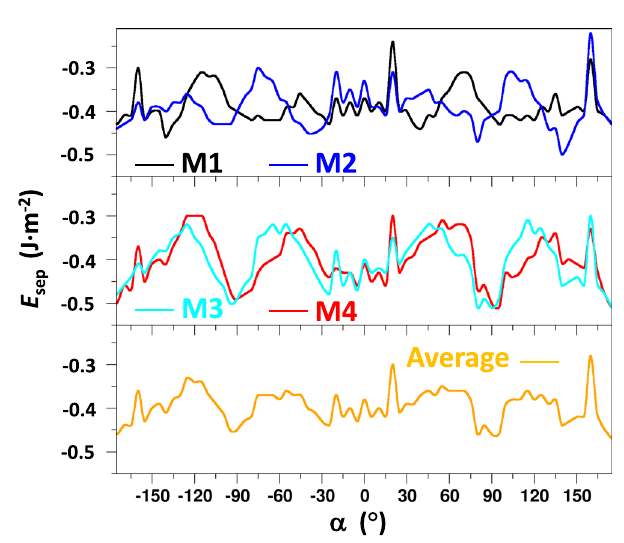
Fig. 4 | Twist angle dependence of (101)/(001) interface energetic stability. Calculated E sep values of the four lowest energy (101)/(001) interfaces circled in Fig.2(i.e.M1,M2,M3andM4),asafunctionofthein-planetwistangle( α )sampled every 5°. The lower plot shows the average E sep of all four